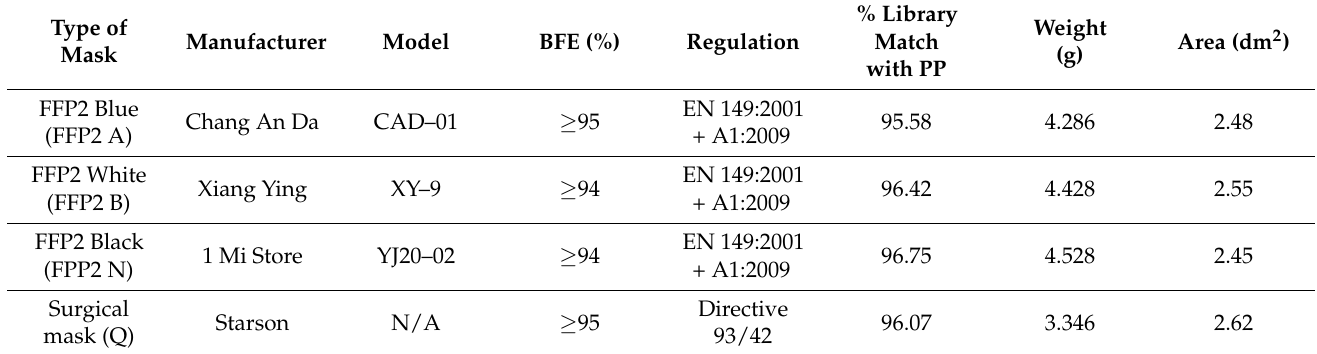
Table 1. Masks used to perform the migration study, indicating the manufacturer and the model, the Bacterial Filtration Efficiency (BFE), the regulation and the result of the FT-IR analyses expressed as % match with library spectra. Weight (without strings) and area of masks also